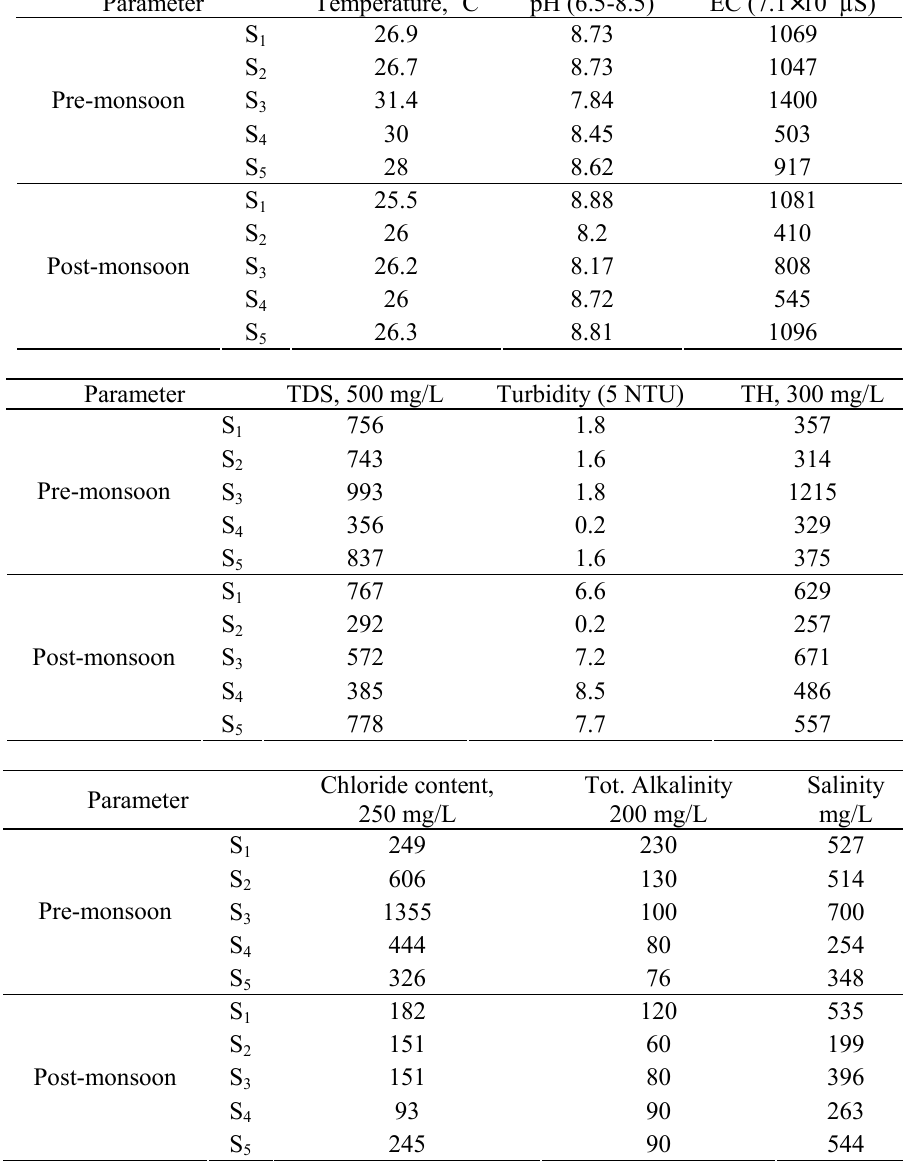
Table 2. The physicochemical parameters of various samples for pre-monsoon and post- monsoon seasons (parenthesis indicates units / desirable